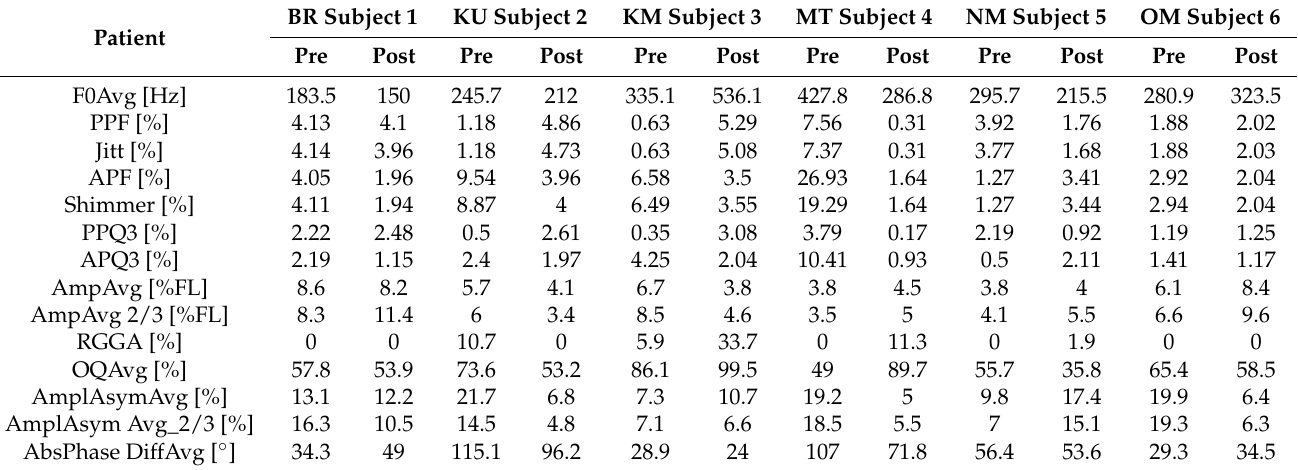
Table 1. Parameters describing abnormalities in frequency and amplitude of phonatory vibrations calculated on the basis of kymograms from HSV recordings.